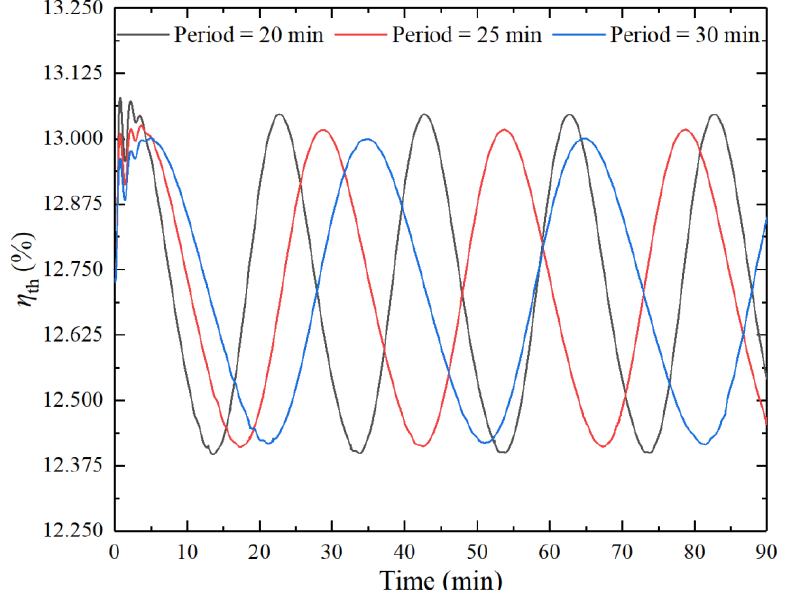
Figure 14. Thermal efficiency under different periods.